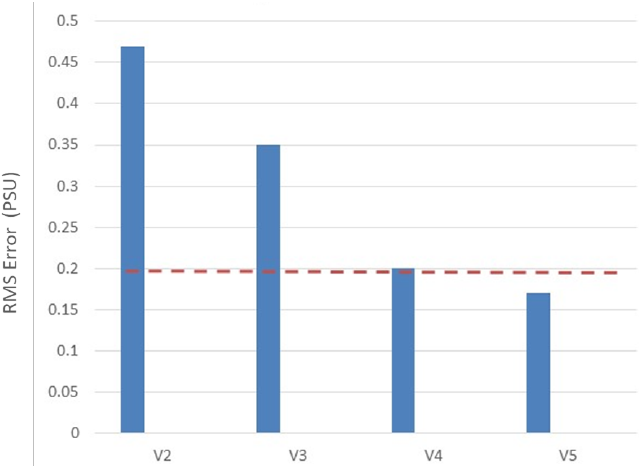
Figure 3. Aquarius SSS retrieval RMS error estimated with a triple point analysis using Aquarius, Hybrid Coordinate Ocean Model (HYCOM), and Argo data. The results shown are for the Aquarius middle beam. The dashed line represents the Aquarius mission requirement for monthly maps at 150-km spatial resolution. The data are from Table 1 in Kao et al. [22]. The version of HYCOM used by the Aquarius project is the HYCOM + NCODA Global 1/12 ◦ Analysis (GLBA0.08).